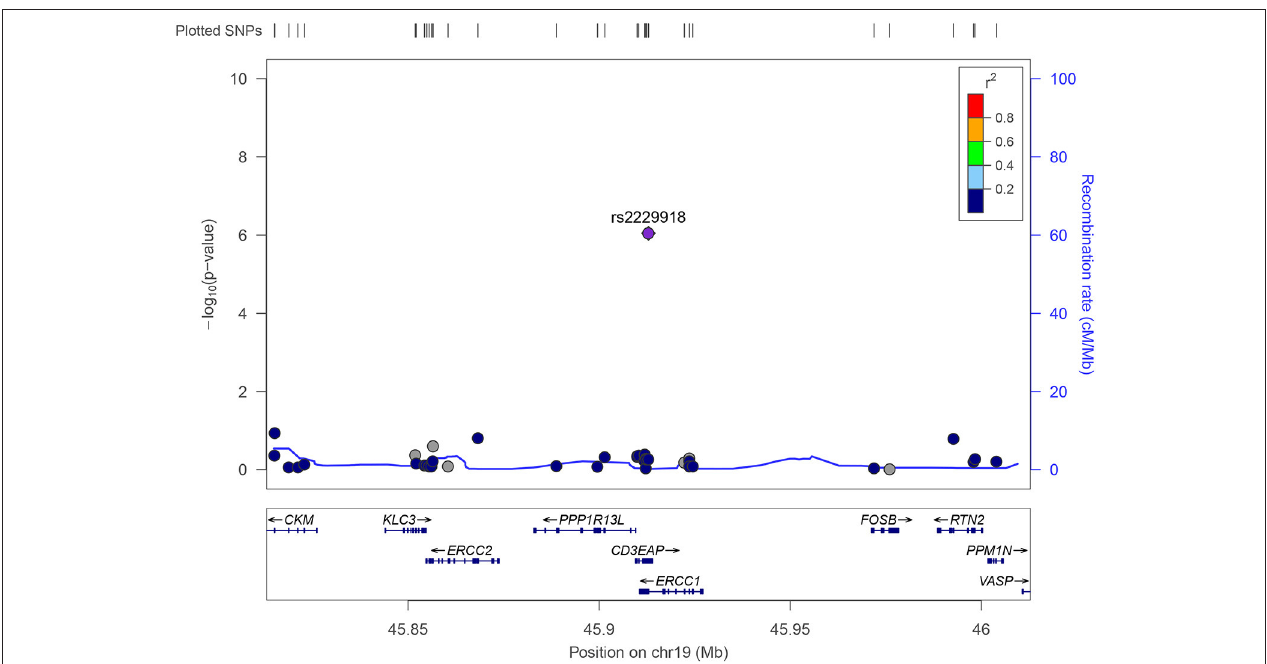
FIGURE 3 | Regional association plot for rs2229918. Rs2229918 is located in purple. The dots show the variants tested in this region on chromosome 19. The − log10 transformed p -values are plotted on the y-axis and the genes and positions of the variants (Mb) in this region are depicted on the